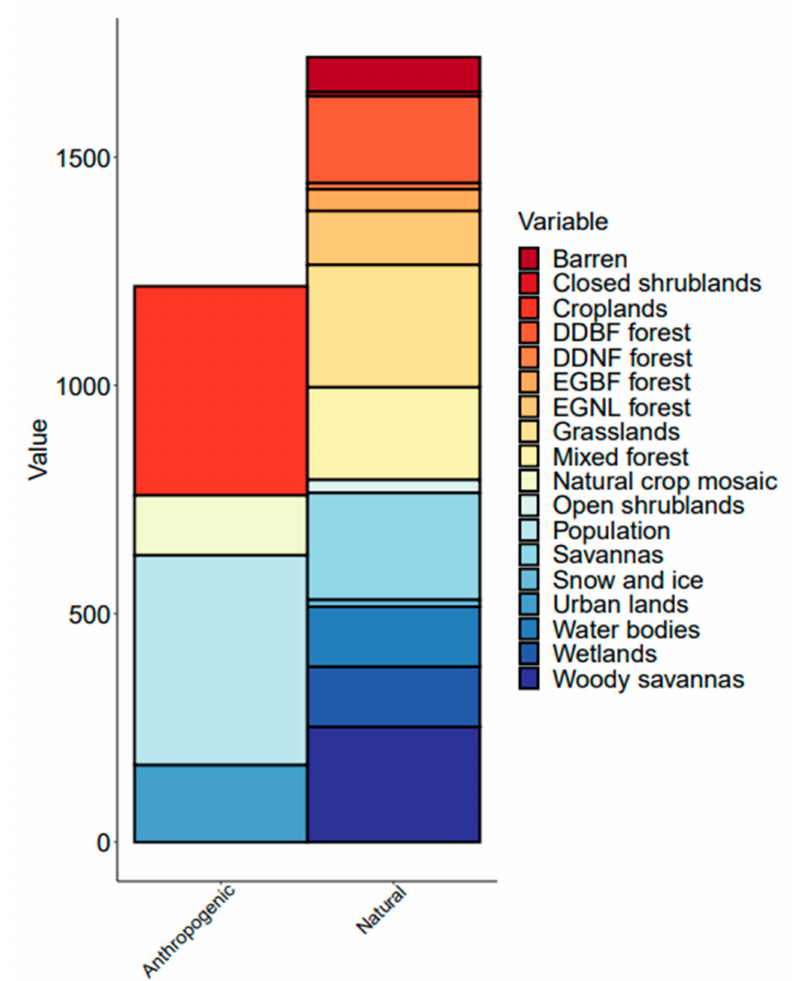
Figure 5. Stacked bar plot representing the relative explained variation of each land cover category and human population in the random forest model. The variables are all drivers of chlorophyll in the pseudo-watersheds of the 9313 analyzed lakes. The x -axis shows the grouping of anthropogenic and natural categories. The y -axis shows the importance of each variable to the random forest. The acronyms are as follows: DDBF = Deciduous Broadleaf, EGBF = Evergreen Broadleaf, DDNF = Deciduous Needleleaf, EGNL = Evergreen